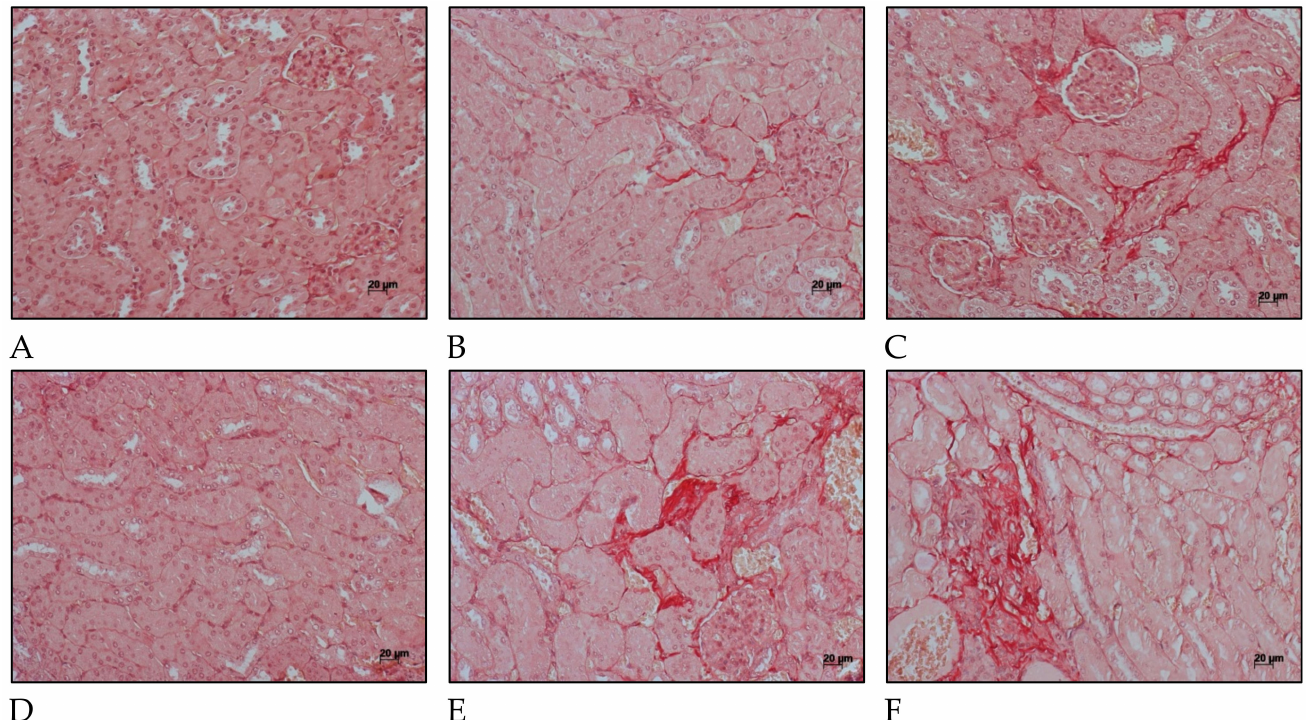
Figure 4. Histology micrography from C57BL/6 mice kidneys infected by Leptospira interrogans sorovar Manilae str, L495. Collagen deposition is evidenced by red staining in peritubular and perivascular areas and the interstitium. ( A , D ) Negative control injected with 200 µ L of PBS, 15 days post-infection (d.p.i.) and 30 d.p.i, respectively; ( B , C ) Kidneys of mice injected with 1 × 10 6 Leptospira and 2 × 10 8 Leptospira , respectively, at 15 d.p.i.; ( E , F ) Kidneys of mice injected with 1 × 10 6 Leptospira and 2 × 10 8 Leptospira , respectively, at 30 d.p.i.; Picrosirius Red staining, lateral bar = 20 µ